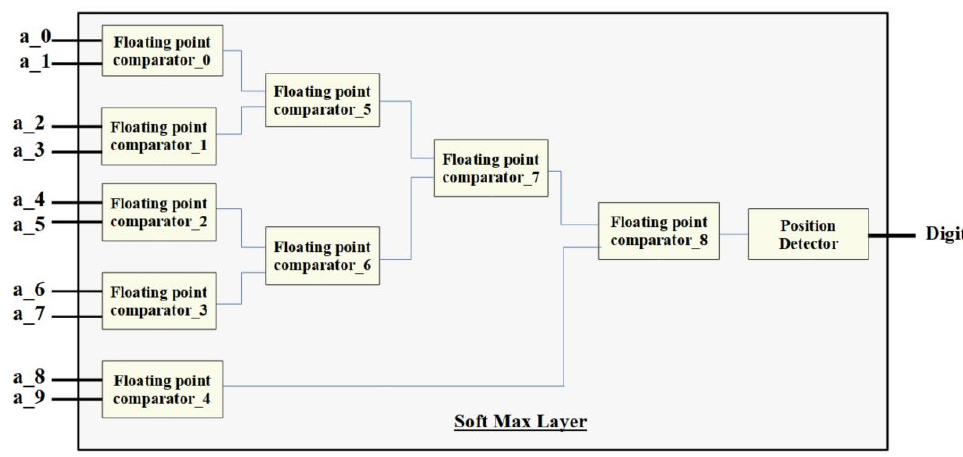
Figure 12. Visual representation of the softmax layer using FP comparators.